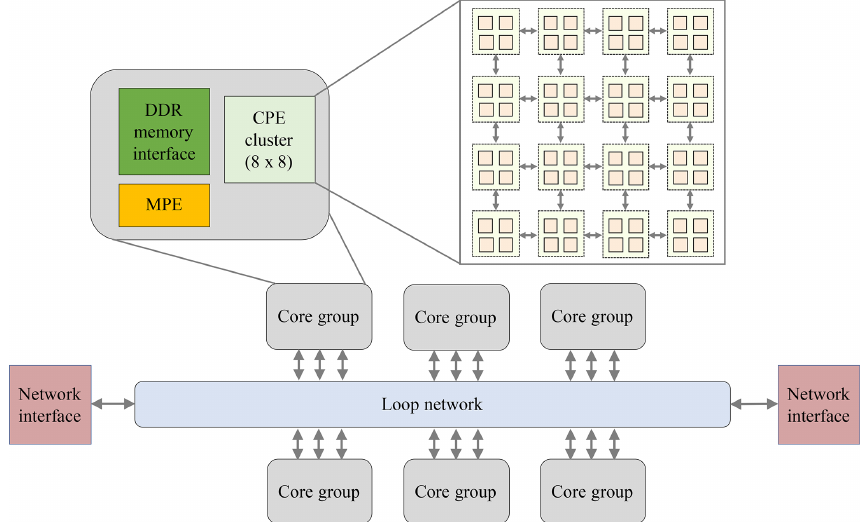
Figure 2. Architecture of the new-generation Sunway supercomputer.